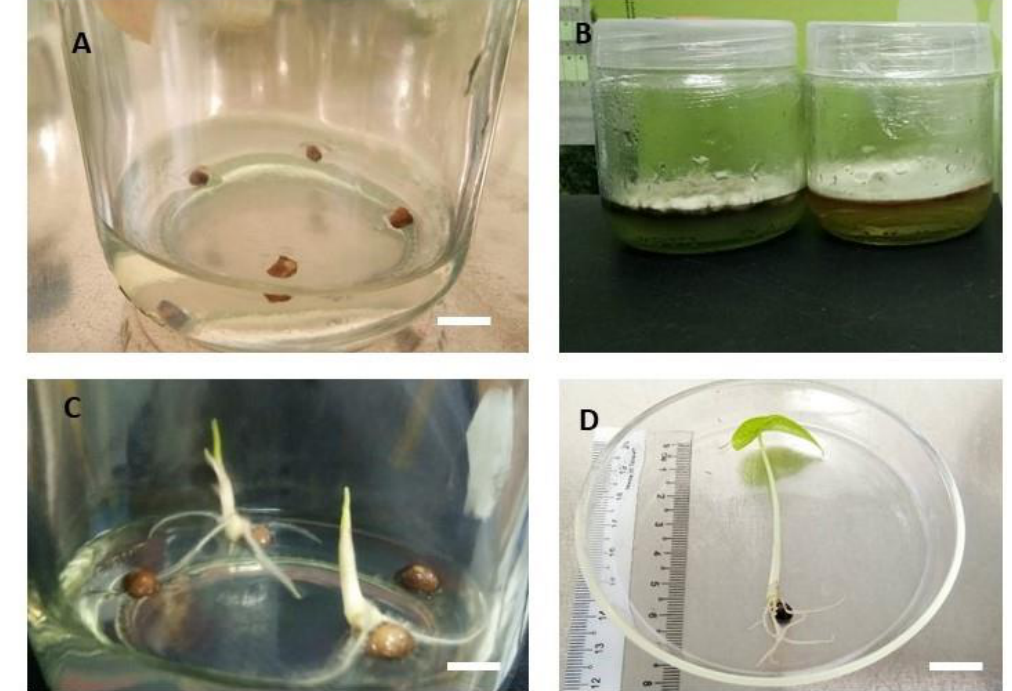
Figure 3. Seed culture of A. longiloba . ( A ) seed on the first day before contamination sets in; ( B ) contaminated culture; ( C ) germinated seed after 2–3 weeks of culture (bar = 1 cm); ( D ) four weeks old germinated seed explant (bar = 1 germinated seed explant (bar = 1 cm).